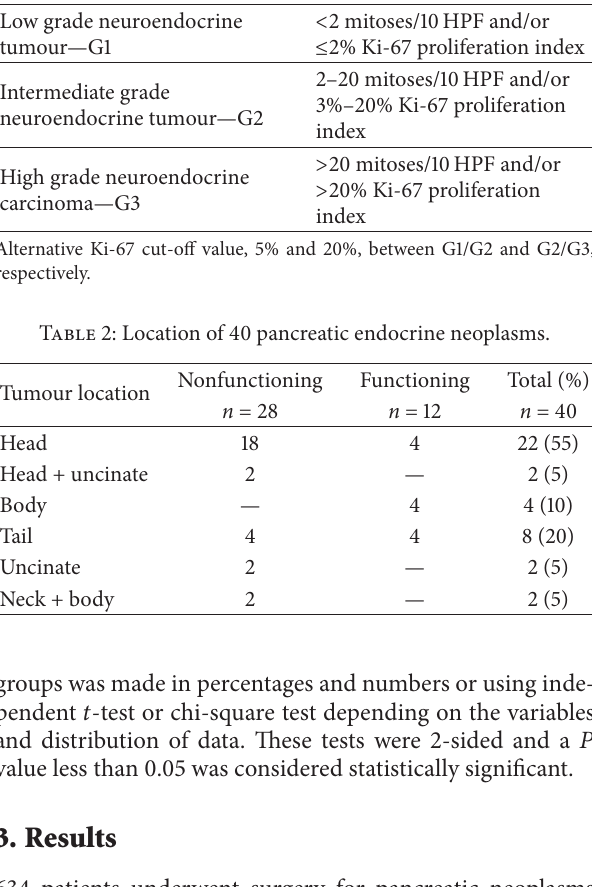
Table 1: WHO grading classification (2010) of pancreatic neuroen- docrine tumours [22].